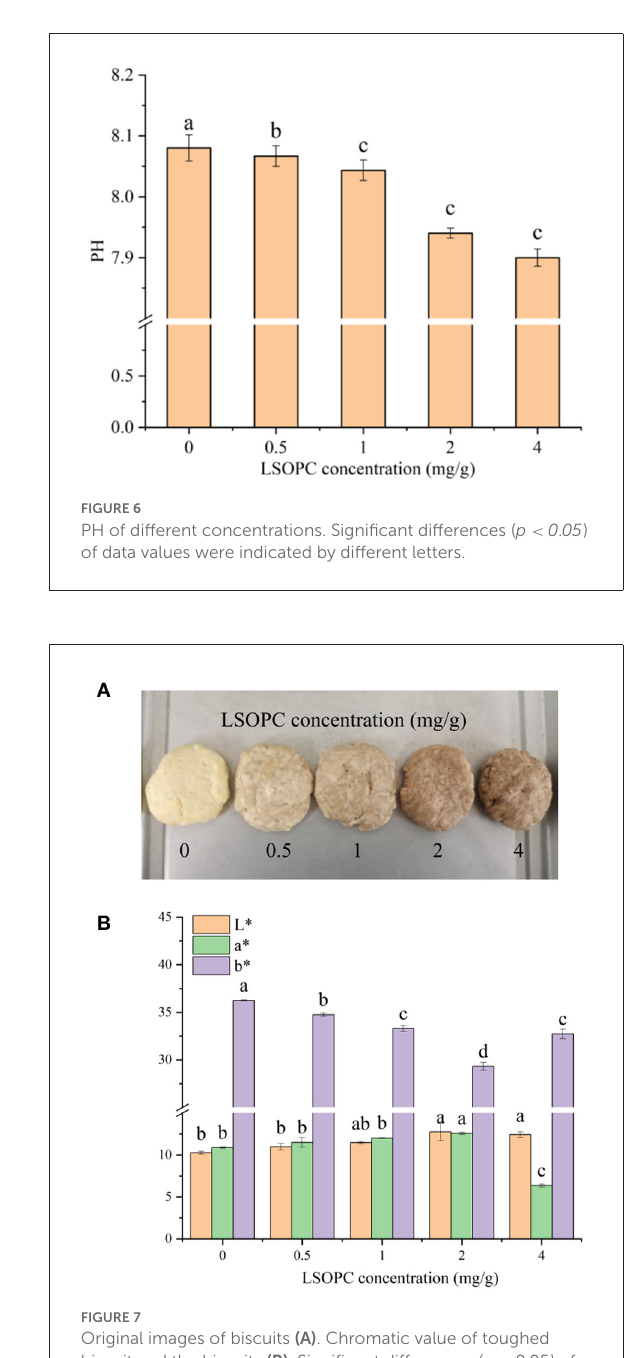
that the high LSOPC-added tough biscuits had the greatest TPC level and the best antioxidant characteristics. Thus, there was a significant correlation between the antioxidant capacity and TPC indicating that phenolic chemicals are the primary contributors of this action